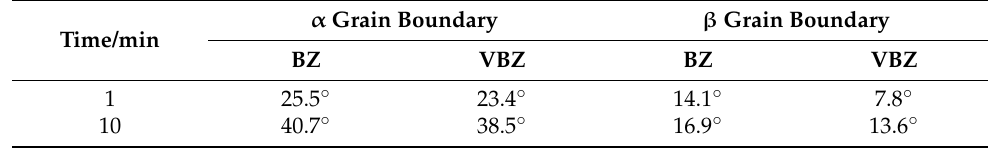
Table 3. Average misorientation of the α and β grain boundaries in BZ and